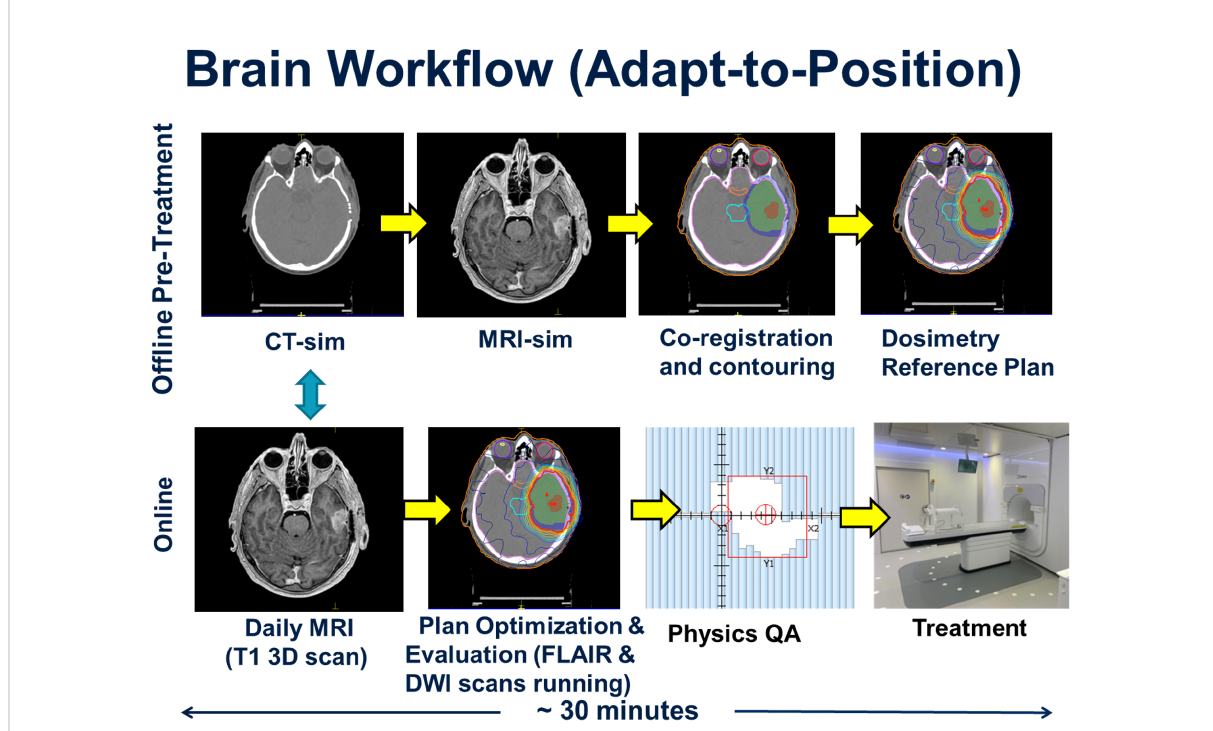
FIGURE 1 Work fl ow for both the of fl ine (upper fi gures) and online (lower fi gures) series of events in the treatment of the 10 glioma patients. The of fl ine pre-treatment work fl ow involves initial simulations and treatment planning that leads to a reference plan. The online portion involves a daily MRI scan used to account for patient setup variations and the generation of a new daily online treatment plan as per the adapt-to-position work fl ow followed by physics quality assurance checks prior to and post treatment. The turquoise arrow indicates the online co-registration between the acquired daily MRI and the reference CT primary data